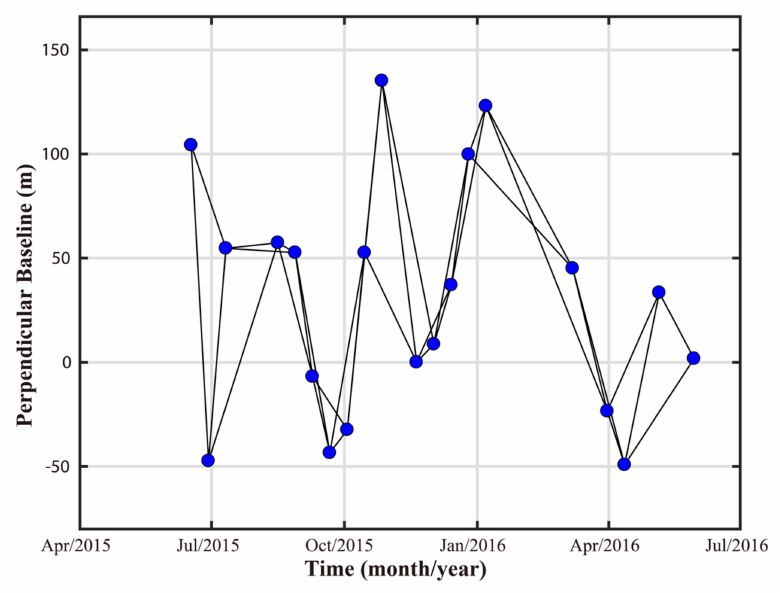
Figure 6. Combination of interferometric pairs. The blue circles represent the SAR images, and the black lines represent the interferometric